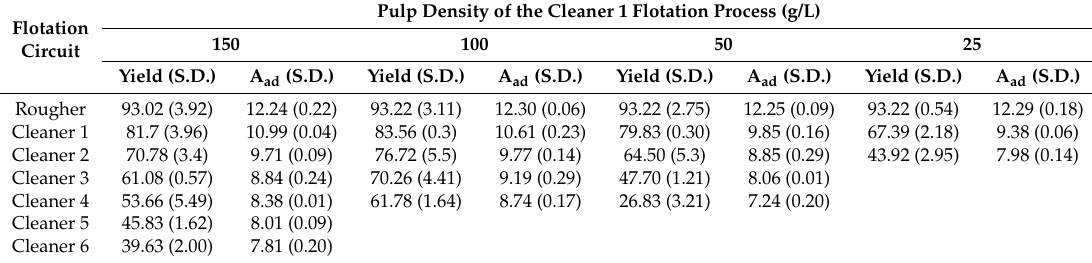
Table 4. Effect of pulp density of the Cleaner 1 flotation process on the concentrate of the multi-stage flotation circuits using a mechanical flotation cell